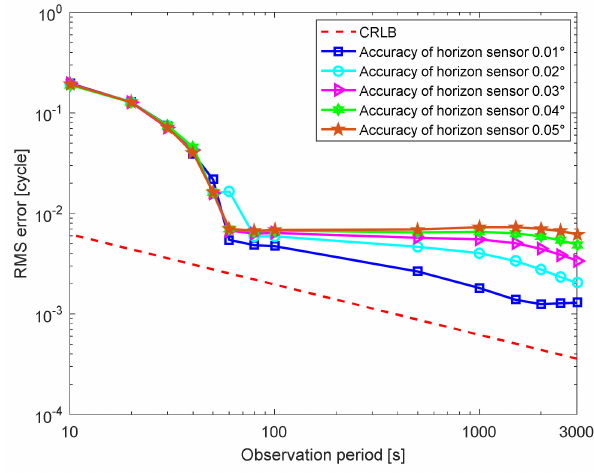
Figure 8. Pulse phase estimation results varying with the accuracy of horizon sensor.